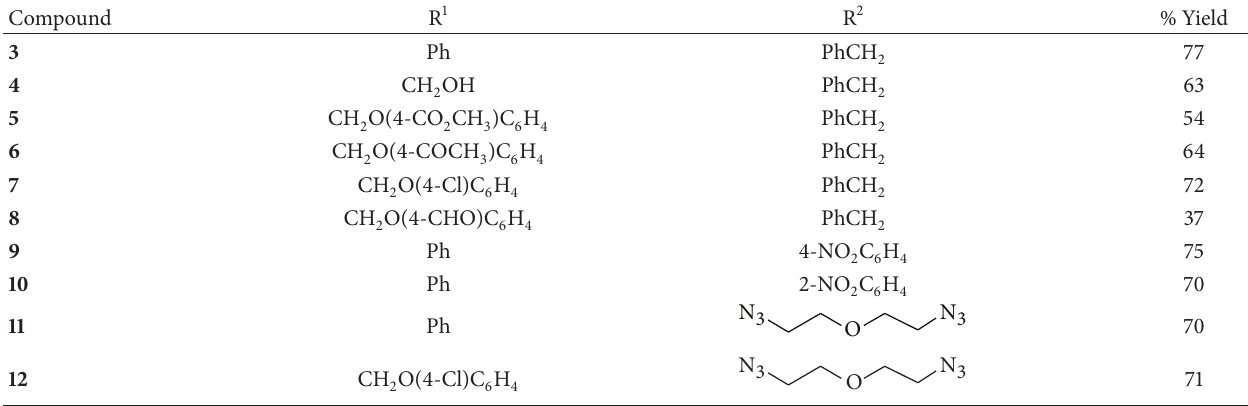
Table 4: Synthesis of triazoles catalyzed by silver complex 14